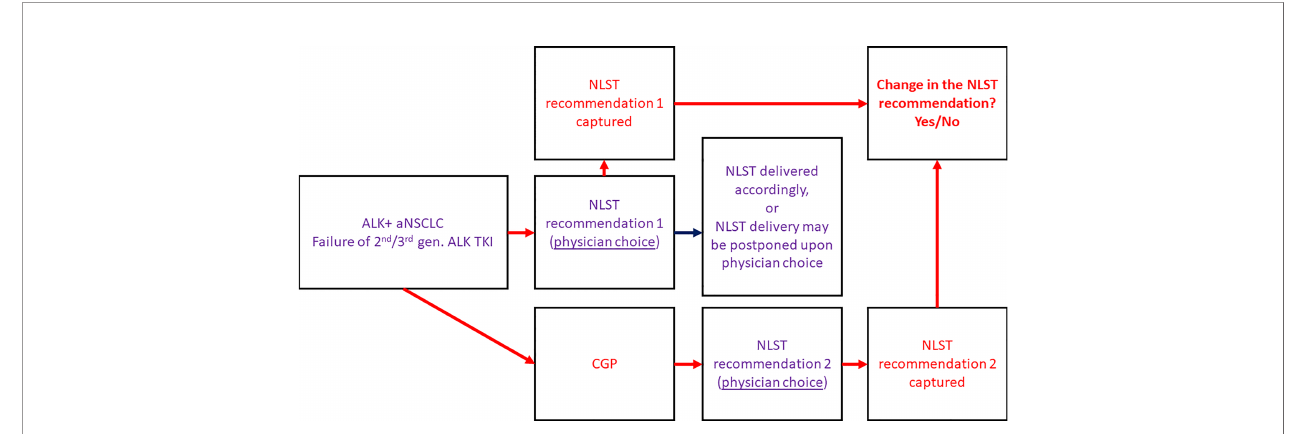
FIGURE 1 | Study design. ALK, anaplastic lymphoma kinase; aNSCLC, advanced non-small cell lung cancer; CGP, comprehensive genomic pro fi ling; gen., generation; NLST, next-line systemic treatment; TKI, tyrosine kinase